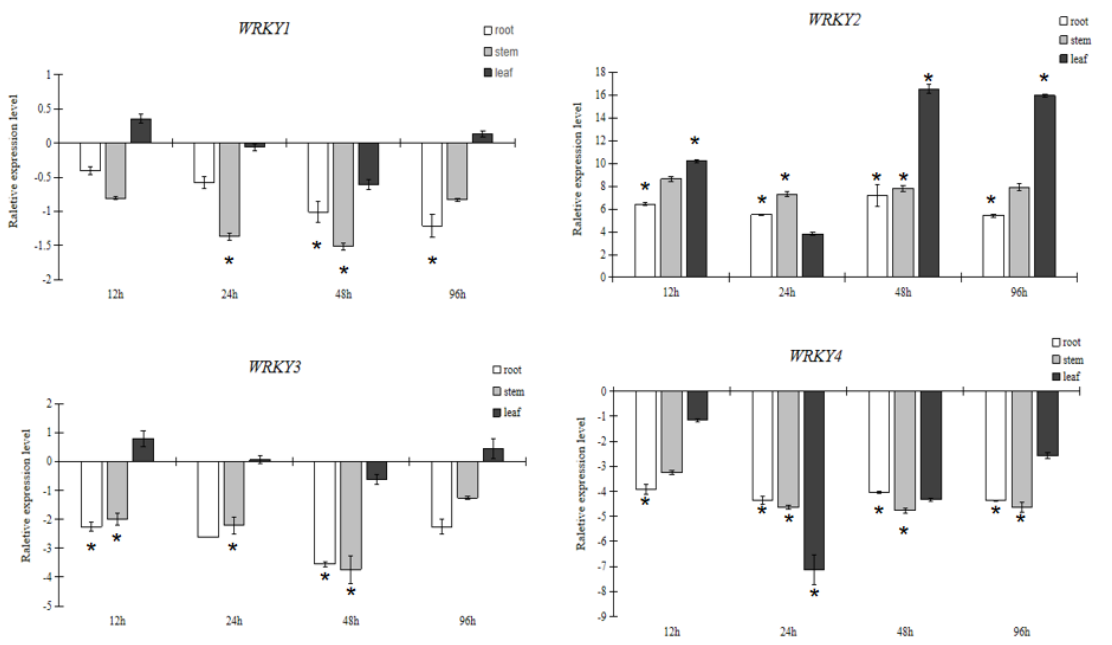
Figure 5. Gene expression levels at 40% PEG 6000 treatment at different times. Note: * indicates a significant difference.